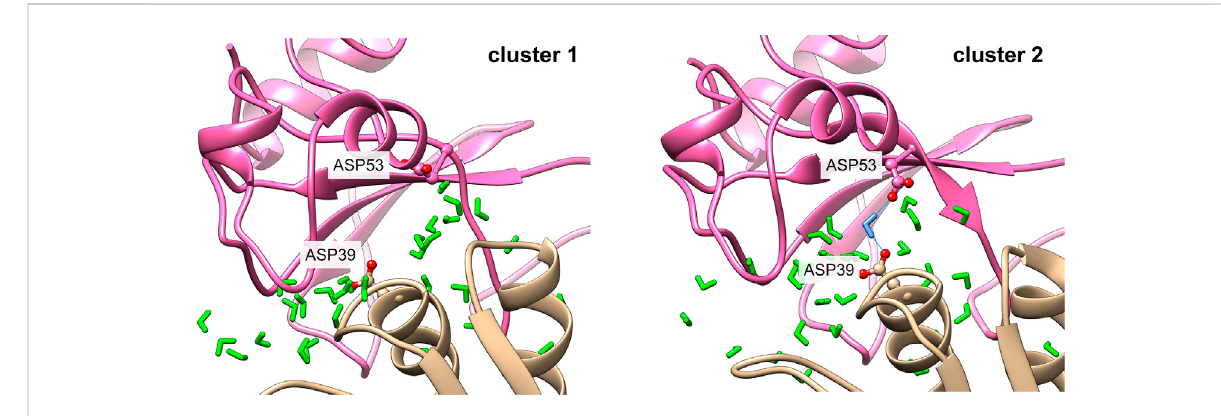
Water-mediated contact in the barnase/barstar complex 1BRS. The contact between Asp 53 of barnase and Asp 39 in barstar is mediated by a water molecule in cluster 2 (right side), with the mediating water molecule in blue. This contact is not observed in cluster 1 (left